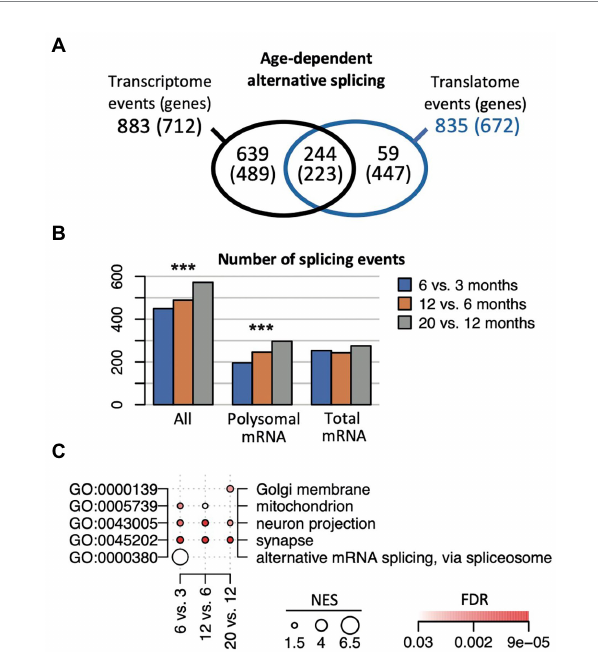
FIGURE 5 Age-dependent alternative splicing (AS) in the transcriptome and translatome. (A) Number of identified AS events and genes (in brackets) across the transcriptome and translatome (polysome). (B) Number of identified splicing events at the indicated time comparisons, considering all genes (all), the ones identified in the polysomes and transcriptome. *** p < 10 − 3 (Chi-square test). (C) Selection of enriched GO terms (FDR < 0.05) across indicated time comparisons considering all AS genes identified in the transcriptome and the translatome. NES for each term proportional to the circle size; FDR values are color